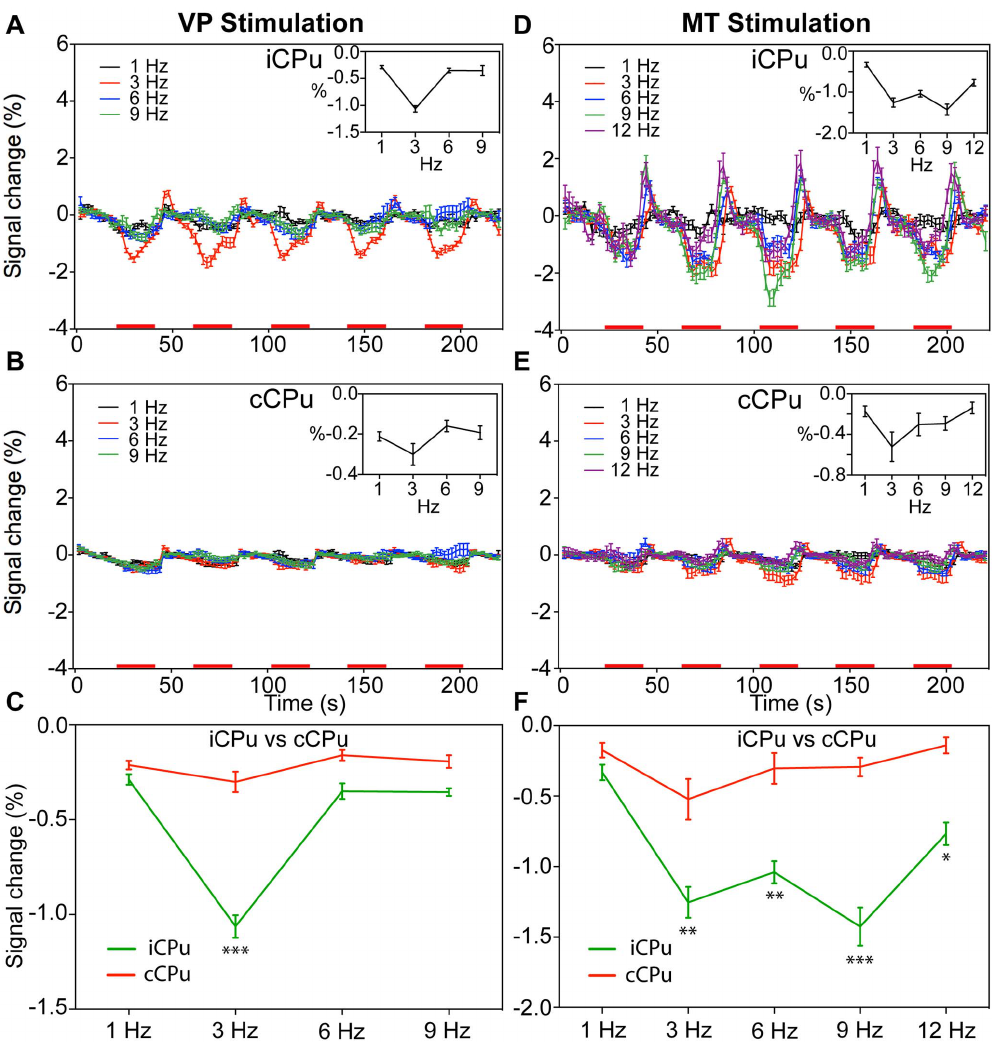
Figure 9. Comparison of negative BOLD responses in the CPu by thalamic stimulation frequencies. Mean time course of BOLD responses (mean 6 SEM) induced by VP (A, B; n=4) and MT (D, E; n=6) stimulation in the iCPu and cCPu, depicted for various stimulus frequencies. Red bars under the time axis show the periods of electrical stimulation. The mean BOLD response amplitude (average change, %) within five stimulus blocks is shown against the stimulus frequency in the inset and composited in (C) and (F). (* p , 0.05, ** p , 0.001, *** p , 0.0005, two-way ANOVA with Newman-Keuls posttest).